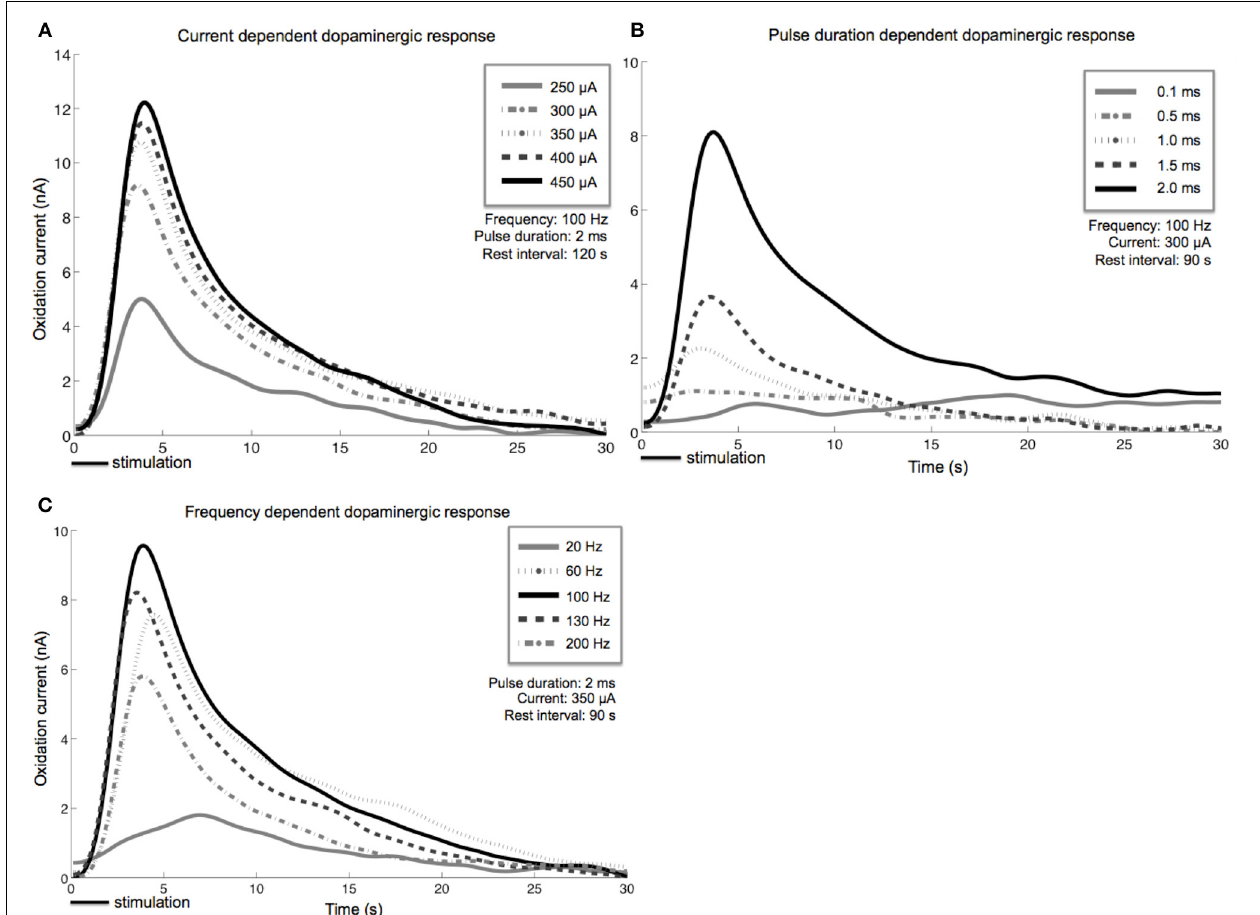
FIGURE 3 | Stimulation-evoked dopamine release characterization in four anesthetized rats. A carbon-fiber recording electrode was implanted into the left striatum and a bipolar stimulating electrode was placed within the ipsilateral medial forebrain bundle. A reference silver-chloride electrode